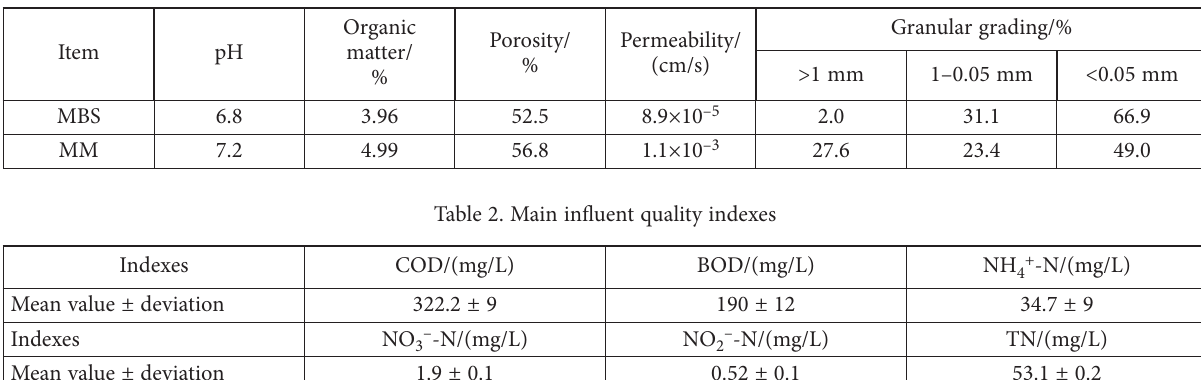
Table 1. Comparison of properties between MBS and MM